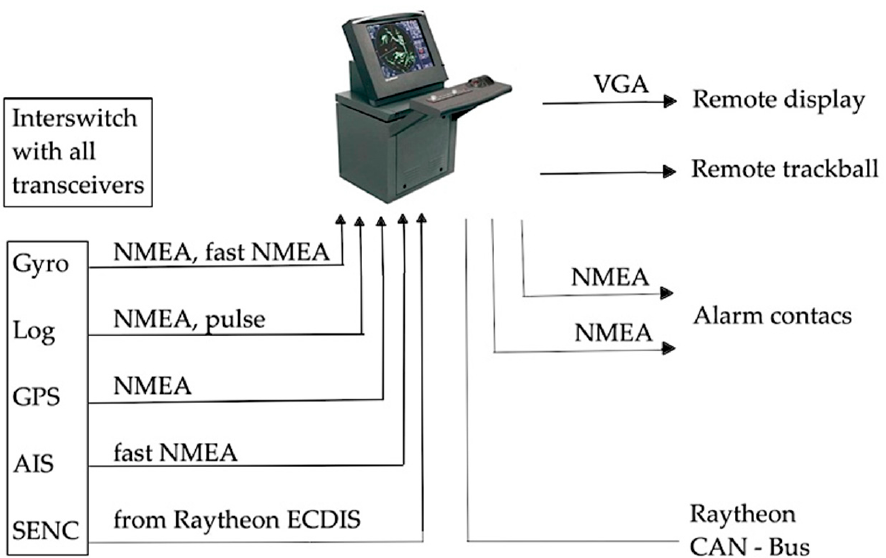
Figure 3. Diagram of standard Raytheon Anschutz radar system interfaces. Data from radar ARPA are downloaded in NMEA 0183 format (IEC 61162-1).